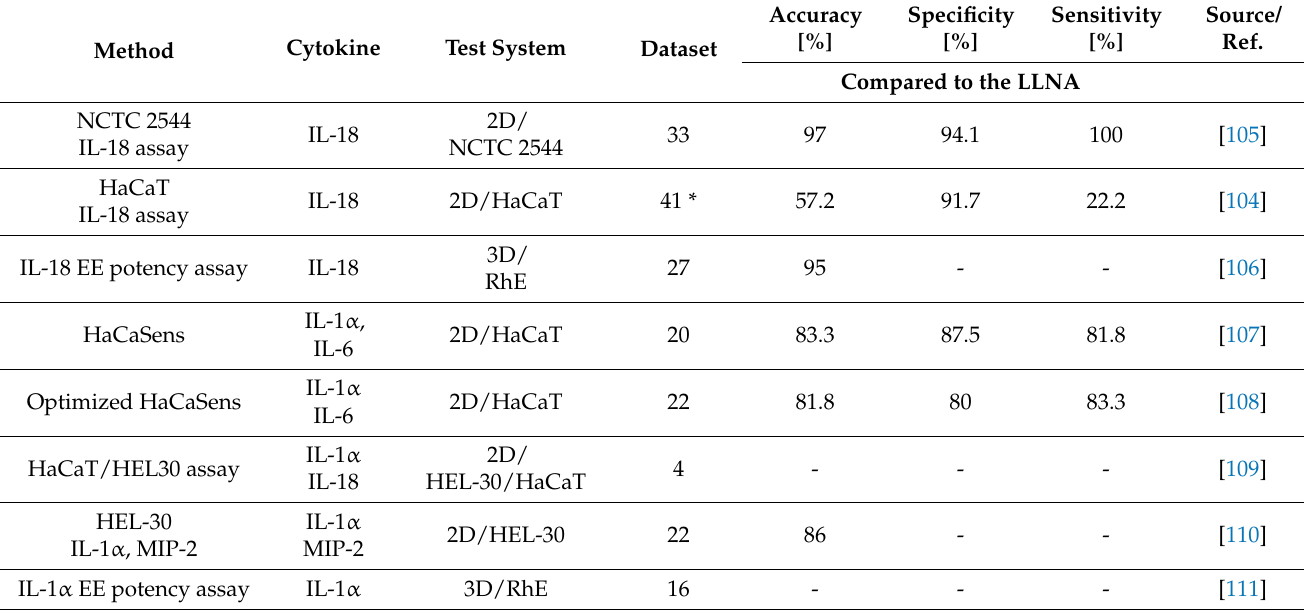
Table 5. KE2. Methods based on the evaluation of proinflammatory